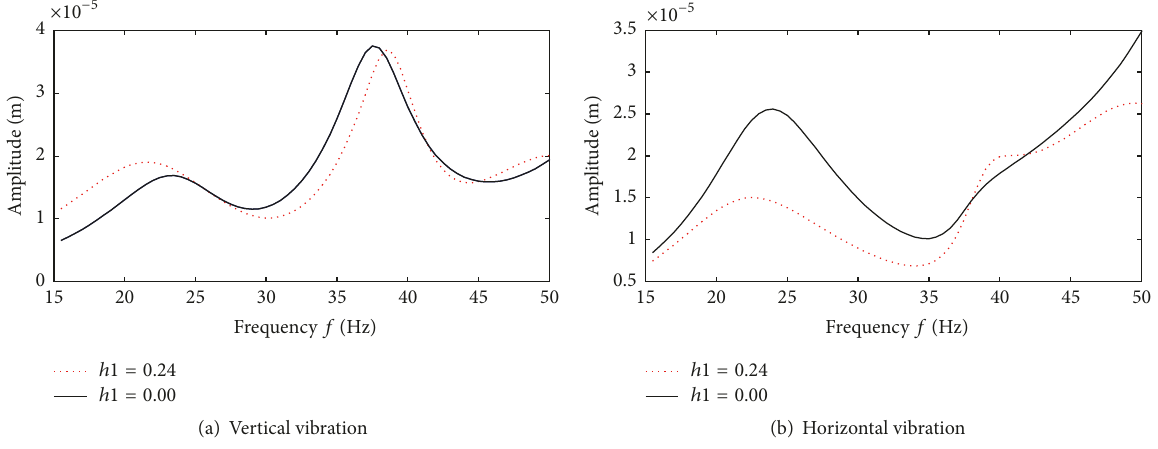
Figure 17: Variation of vibration with rotating speed during run-up process.